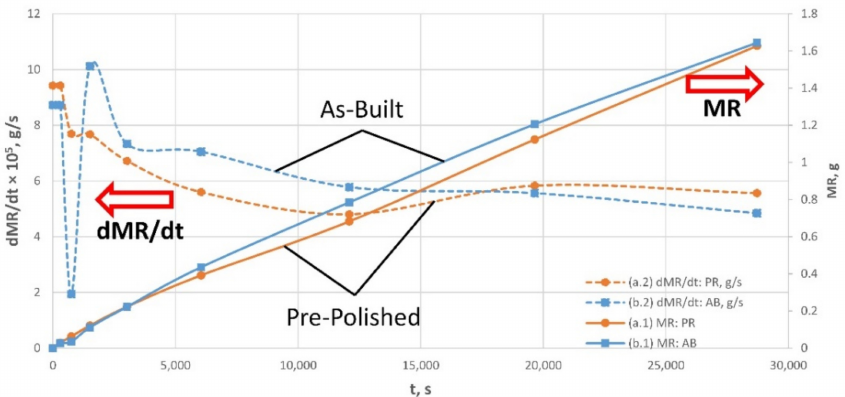
Figure 12. MR ( t ) , dMR / dt ( t ) for the V-shape artifacts: (a) pre-polished: (a.1) MR ( t ) ; (a.2) dMR / dt ( t ) ; (b) As-Built: (b.1) MR ( t ) ; (b.2) dMR / dt ( t ) (average